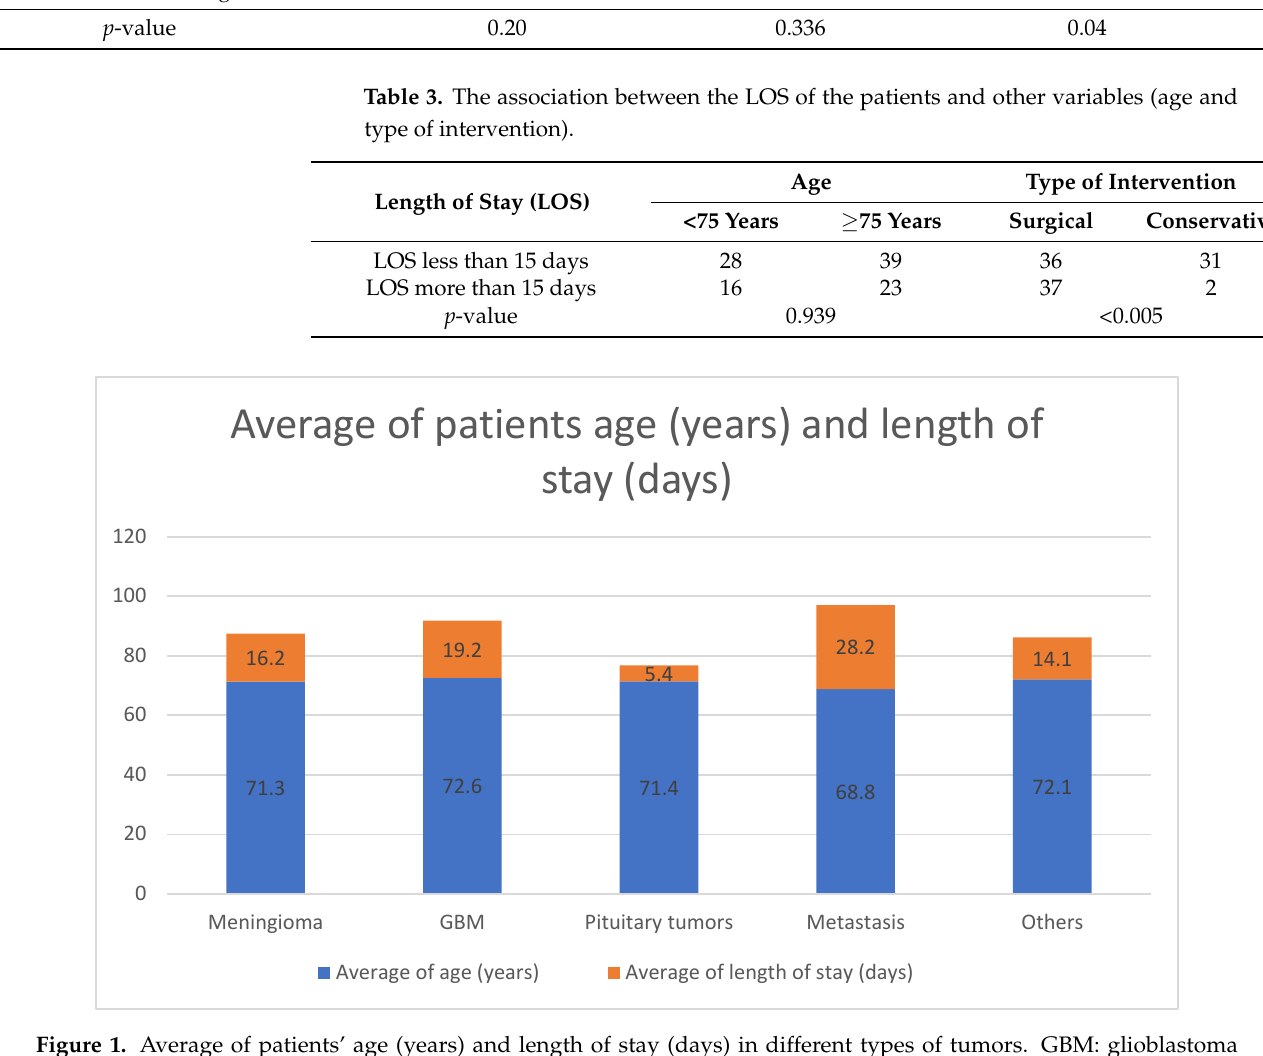
Table 3. The association between the LOS of the patients and other variables (age and type of intervention).